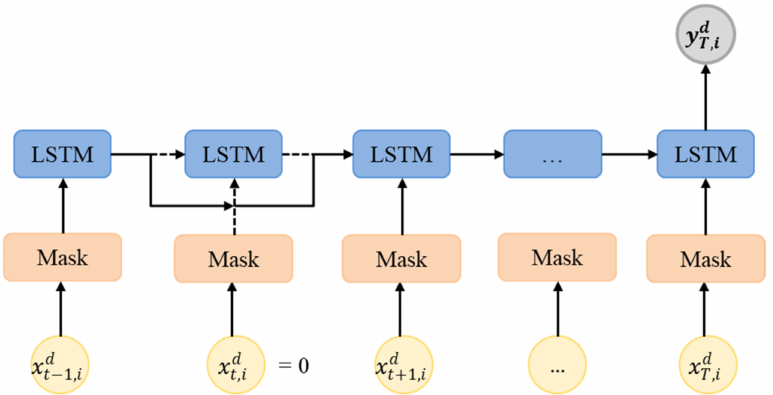
Figure 2. A masked long short-term memory recurrent neural network (mask LSTM RNN) for multiple variables. LSTM, long short-term